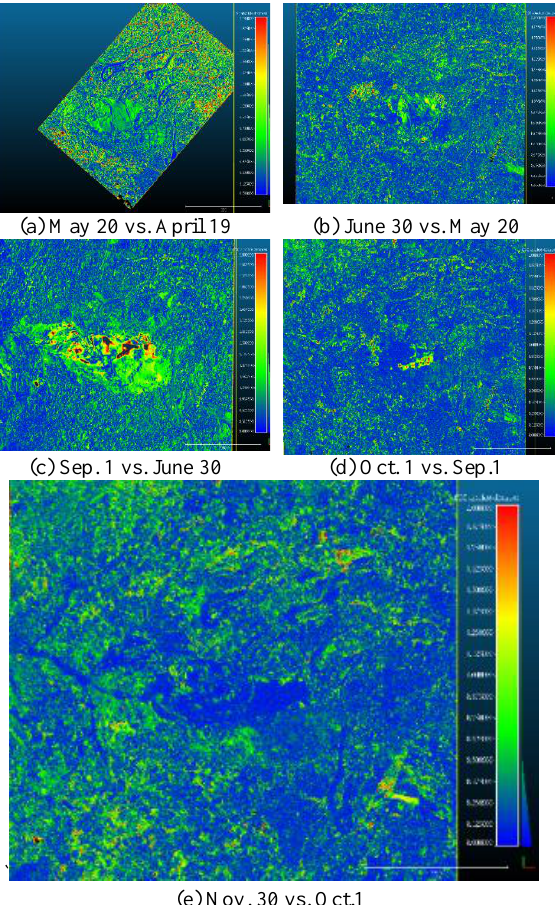
Figure 11. Point-to-point distance between two neighboured point clouds illustrated in pseudo